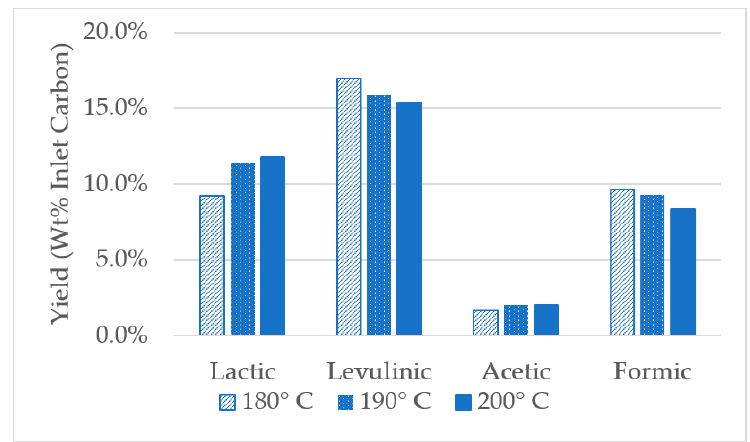
Figure 5. The effect of reaction temperature on the conversion of a corn stover model solution at 5 h reaction time, 2:1 catalyst to sugars ratio, and no additives. The solution contained 65 wt% glucose and 35 wt% xylose.